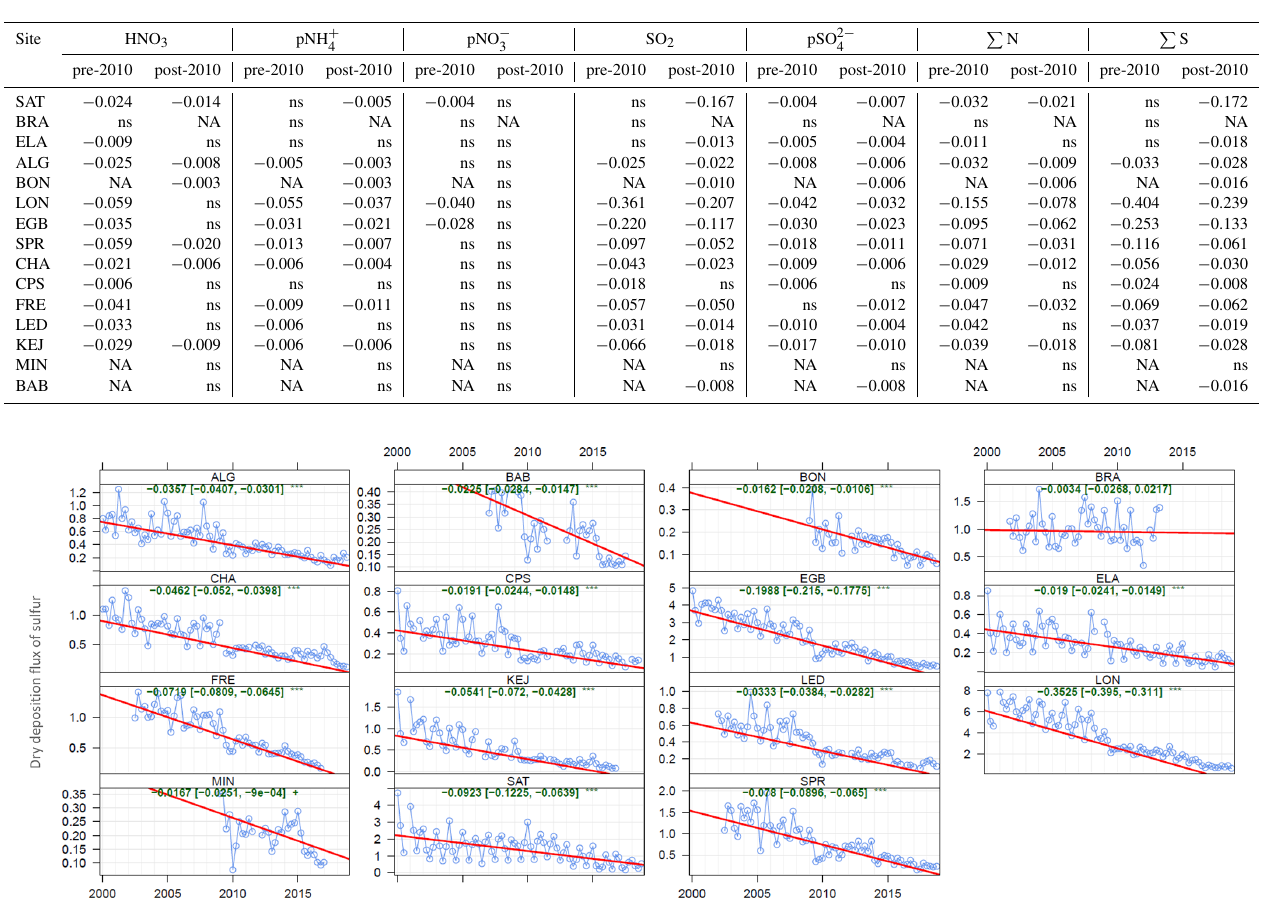
Figure 5. Annual trends in dry deposition fluxes of sulfur at CAPMoN sites (kgSha − 1 yr − 1 ). Theil–Sen slope and 95% confidence interval (green text); trend line de-seasonalized using LOESS (red line); observed seasonal mean dry deposition fluxes (blue time series). Statistically significant trends shown with ∗∗∗ ( p < 0.001) or + ( p <